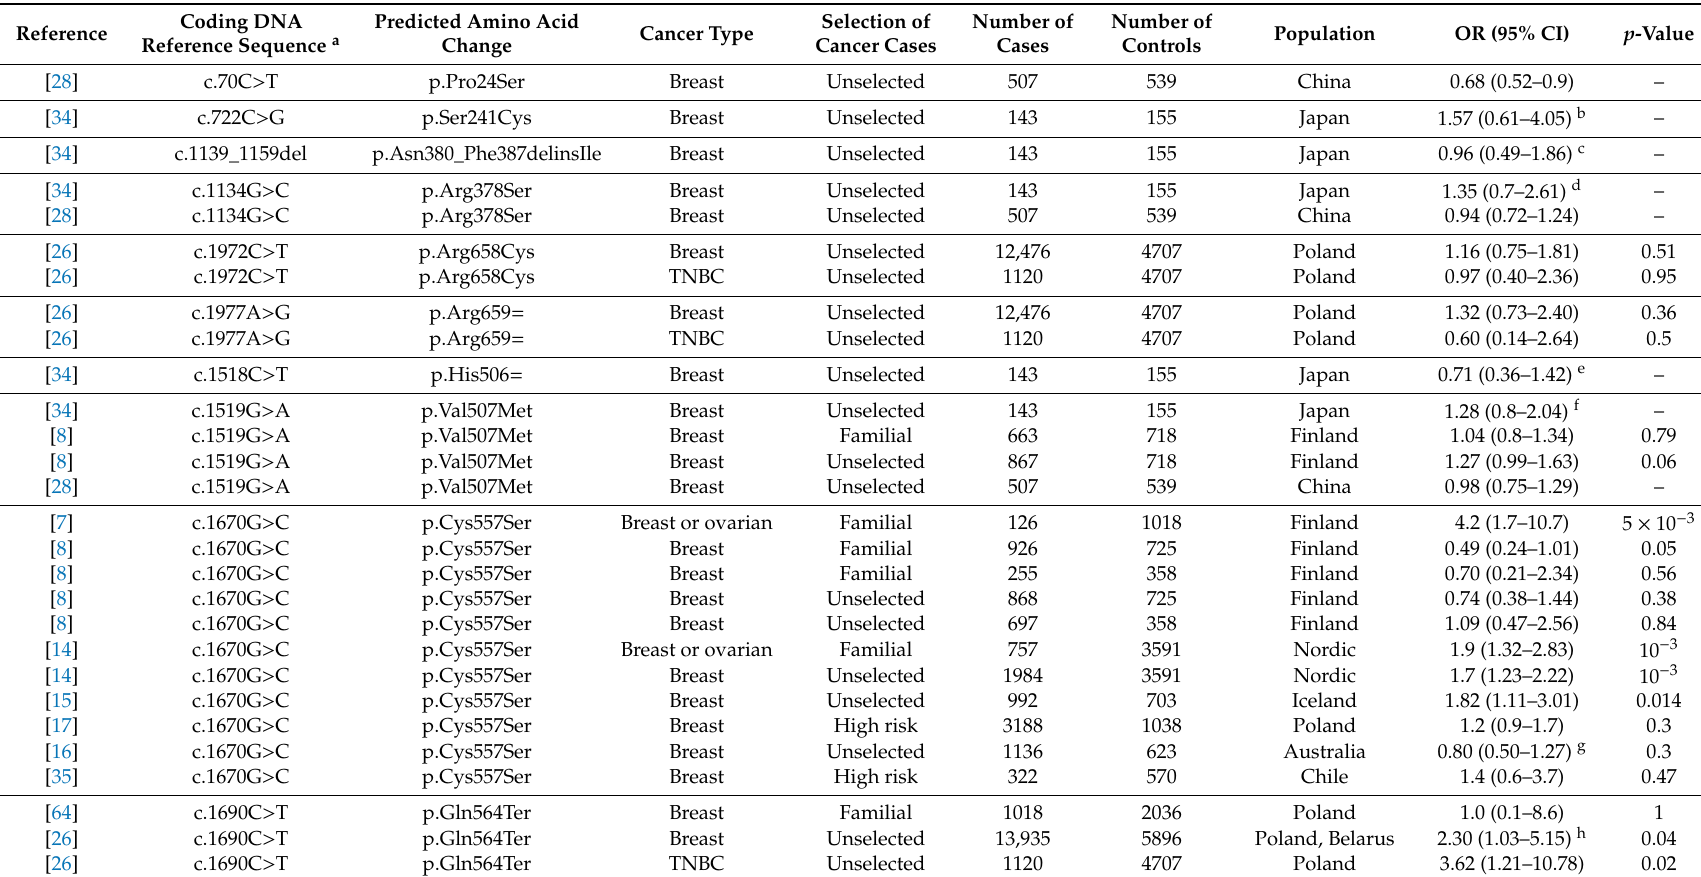
Table 2. Risk of breast or ovarian cancer associated with potentially pathogenic BARD1